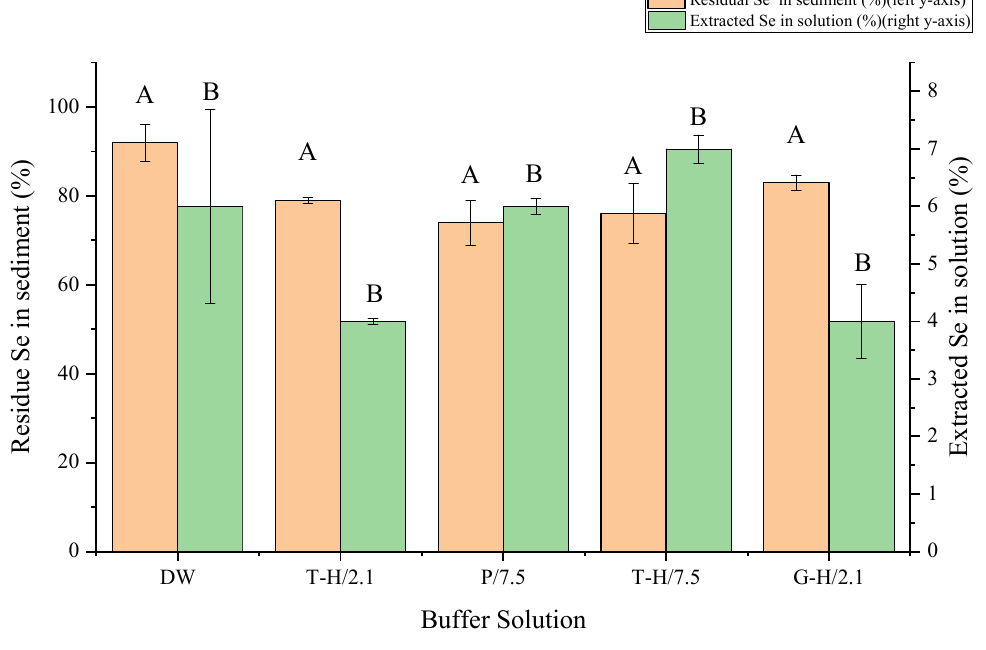
Figure 1. Extraction efficiency with 5 different buffer solutions. Note: DW-Deionized water; T-H/2.1- Tris-HCl (pH = 2.1); P/7.5-Phosphorous (pH = 7.5); T-H/7.5-Tris-HCl (pH = 7.5); G-H/2.1-Glycine- HCl (pH = 2.1). Different letters indicate significant differences at p < 0.05. Residue Se in sediment (%) = Total Se in sediment/Total Se in Ganoderma lucidum × 100%; Extracted Se in solution (%) = Total Se in supernatant/Total Se in Ganoderma lucidum × 100%.